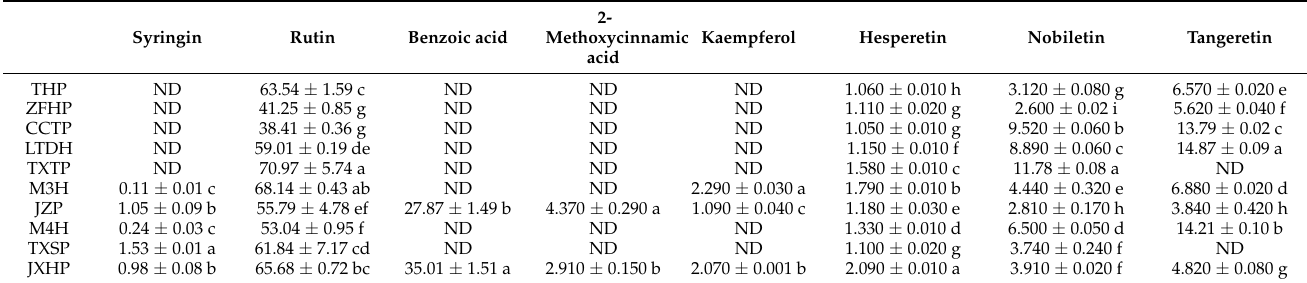
Table 2. Phytochemical components of the sweet and sour wampee varieties ( µ g/g